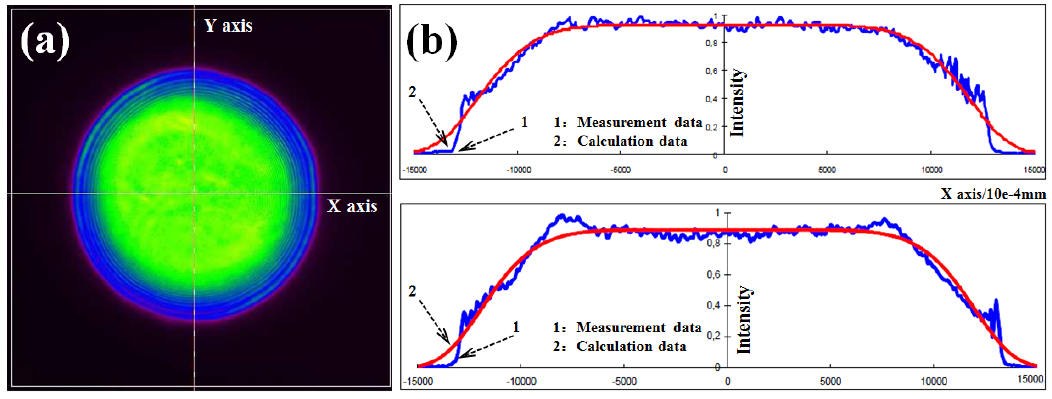
Figure 1. The output beam of single flat-top laser pulse and corresponding spatial profiles along horizontal and perpendicular directions. ( a ) Along horizontal direction; ( b ) along perpendicular direction.